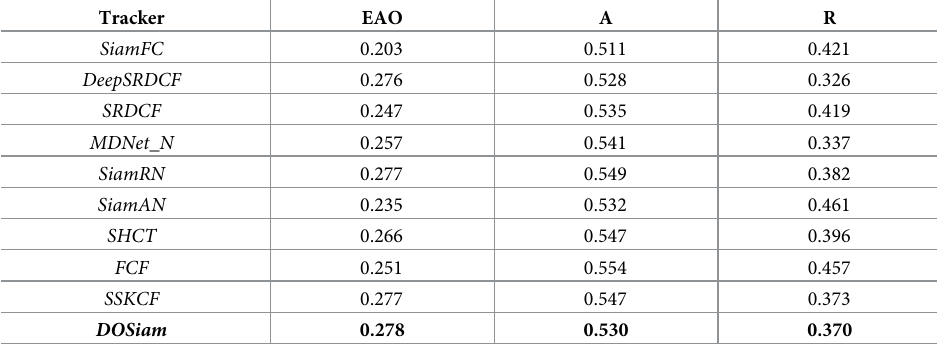
Table 2. Comparison with state-of-the-art trackers on VOT2016 in terms of EAO, A and R.